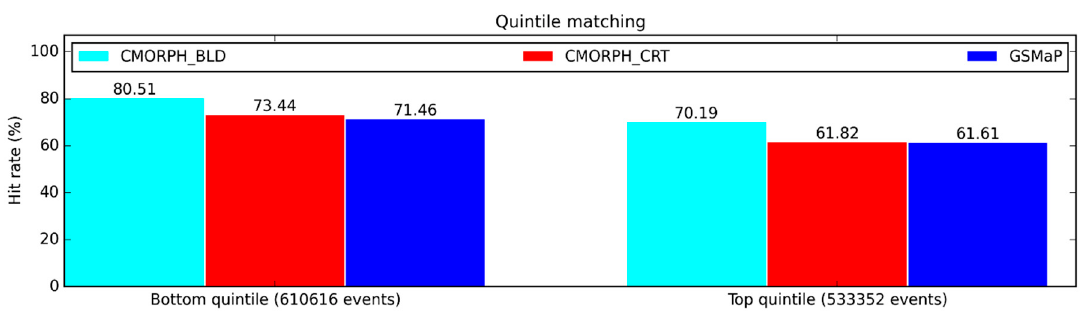
Figure 3. Gridded percentile-based comparison of satellite datasets against AWAP from January 2001 to December 2018. Bottom- and top-quintile hit rates are displayed.